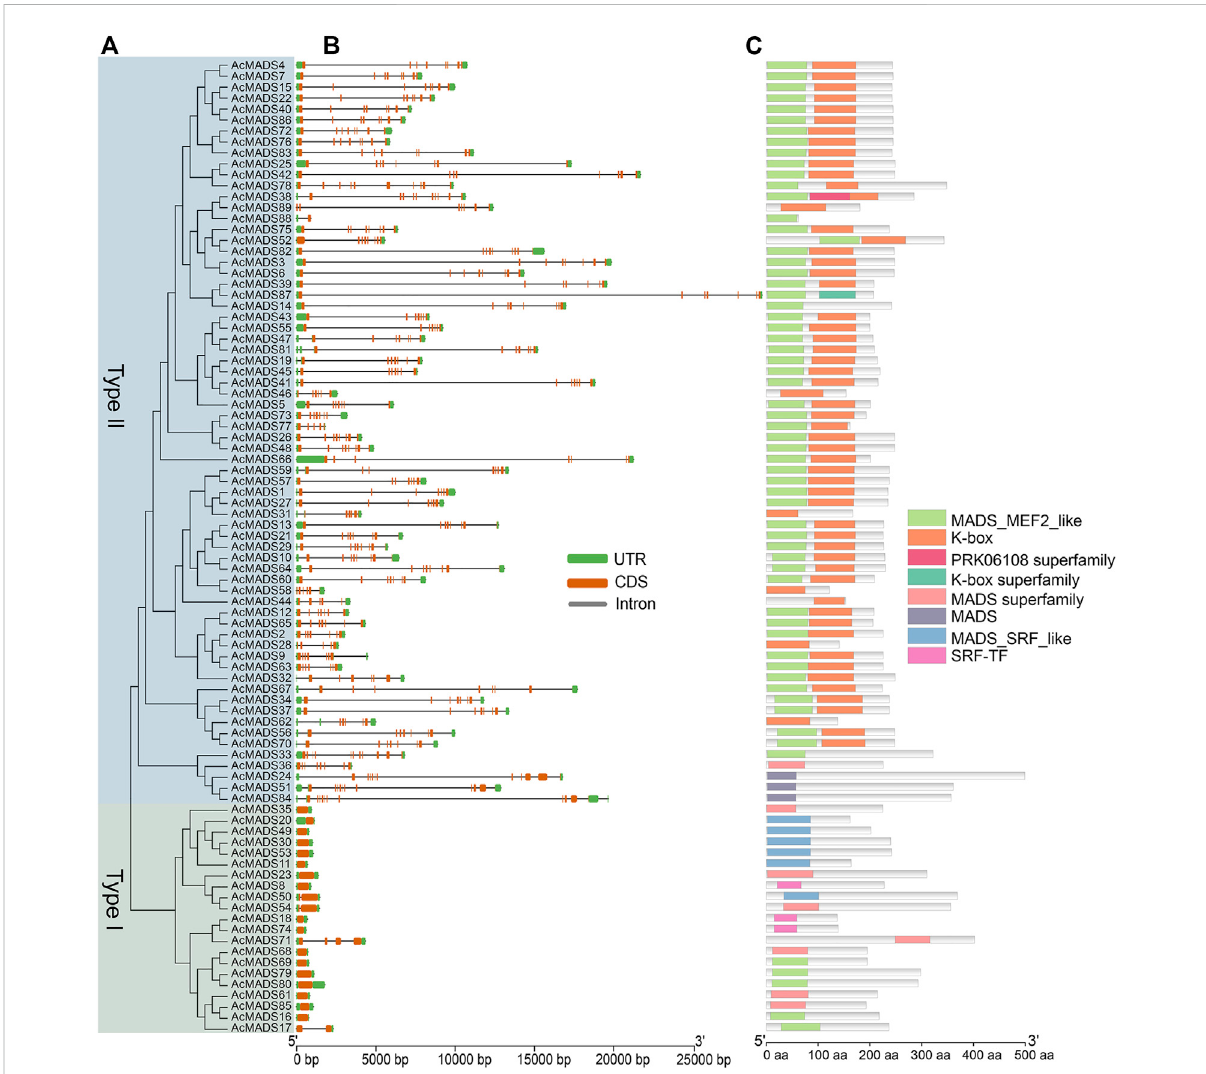
FIGURE 3 Phylogenetic relationships, gene structures, and conserved domains of MADS-box genes in A. chinensis . (A) The phylogenetic tree